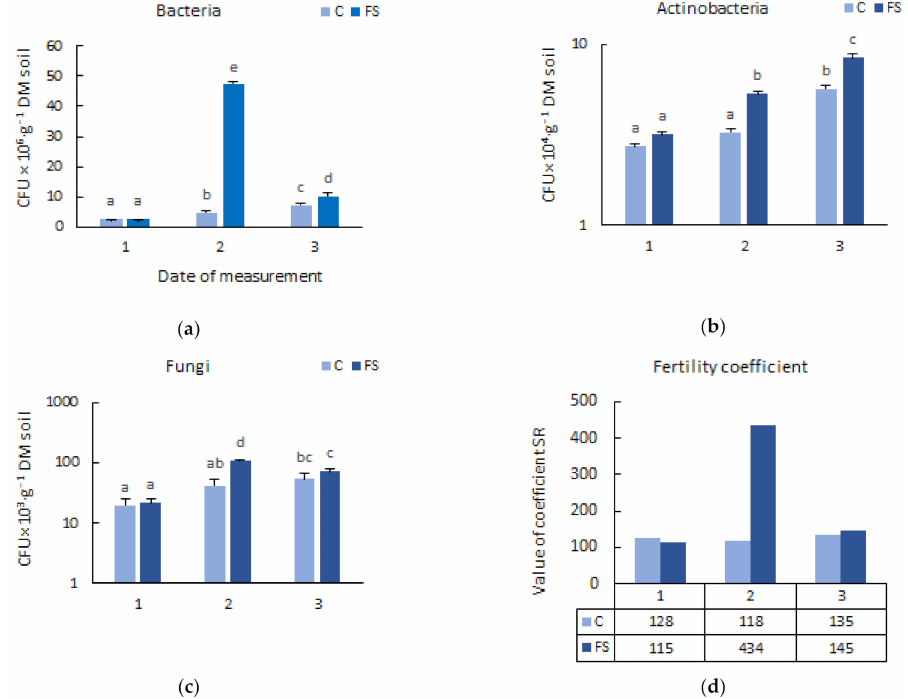
Figure 1. The number of basic taxonomic groups of soil microorganisms and the soil fertility coeffi- cient: ( a ) bacteria, ( b ) actinobacteria, ( c ) fungi and ( d ) fertility coefficient. Different letters above the error bars (i.e., ± SD) indicate significant differences ( p < 0.05) between means (Tukey post-hoc